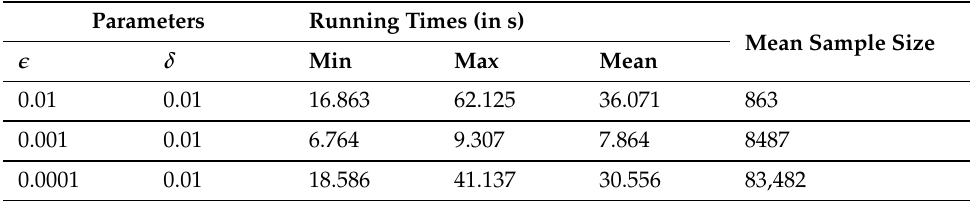
Table 8. E-commerce: PAC DFA extraction from RNN.